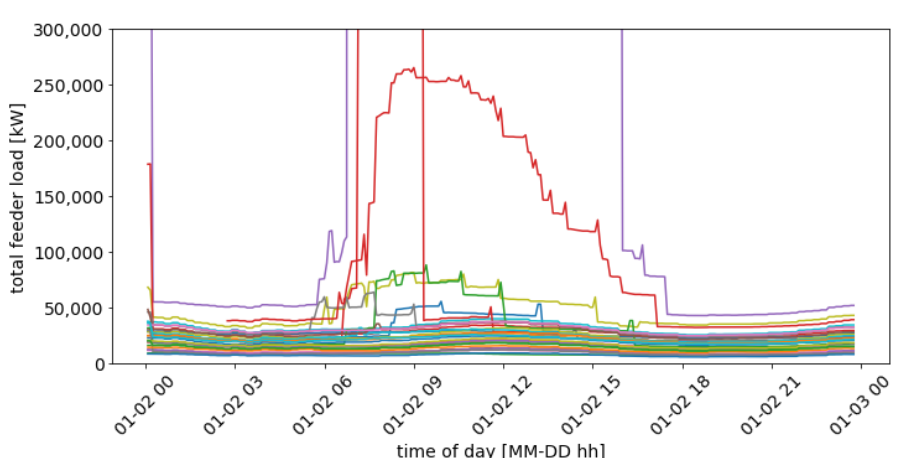
Figure 9. Scenario 3 feeder loads with EV charging.